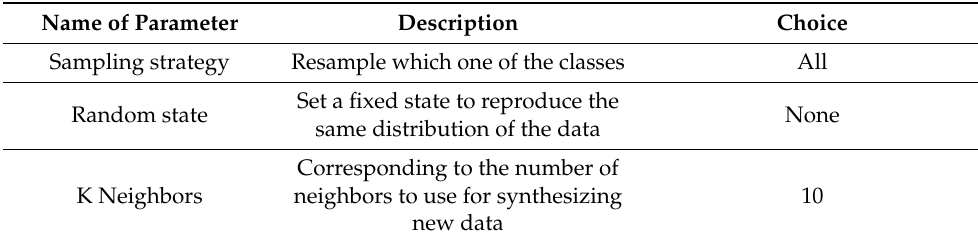
Table 4. The description of the parameters for oversampling